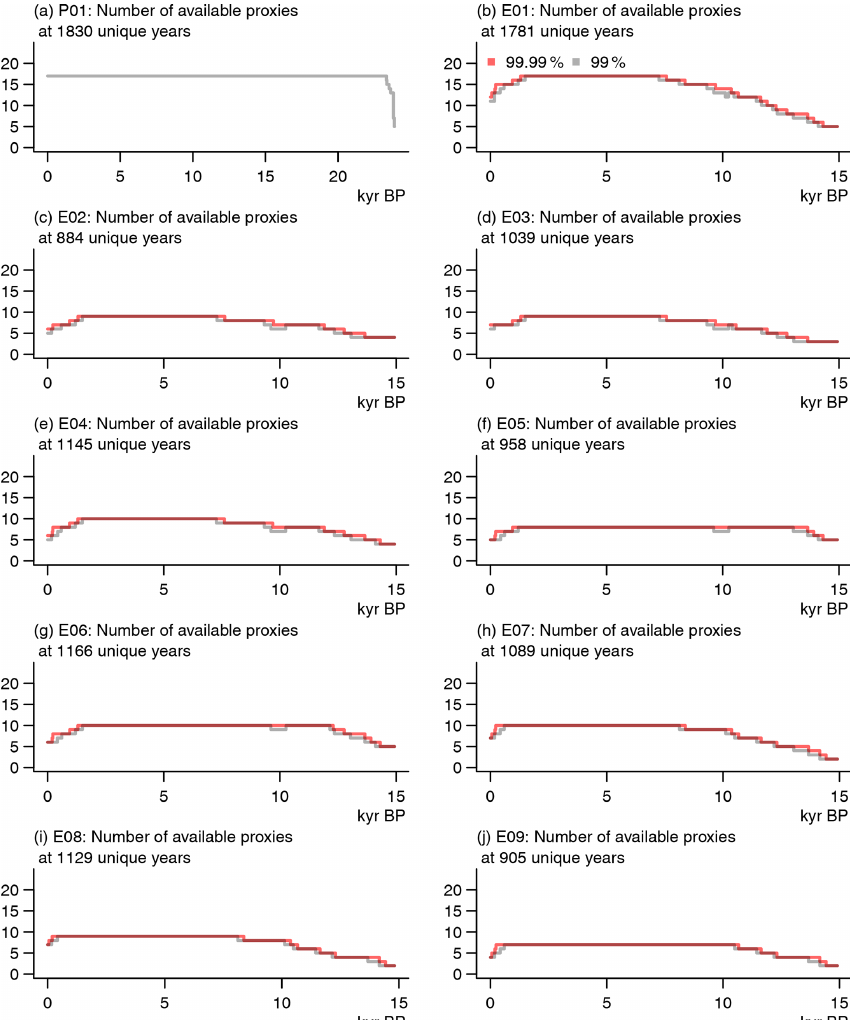
Figure 4. Information about the number of available proxies for the dates to be reconstructed: (a) the pseudo-proxy setup, (b–j) the various proxy setups according to Fig. 3 and Table 1. In panels (b) to (j) , we show results for two different assumptions on the uncertainties: a 99% envelope and a 99.99% envelope (compare Sect.